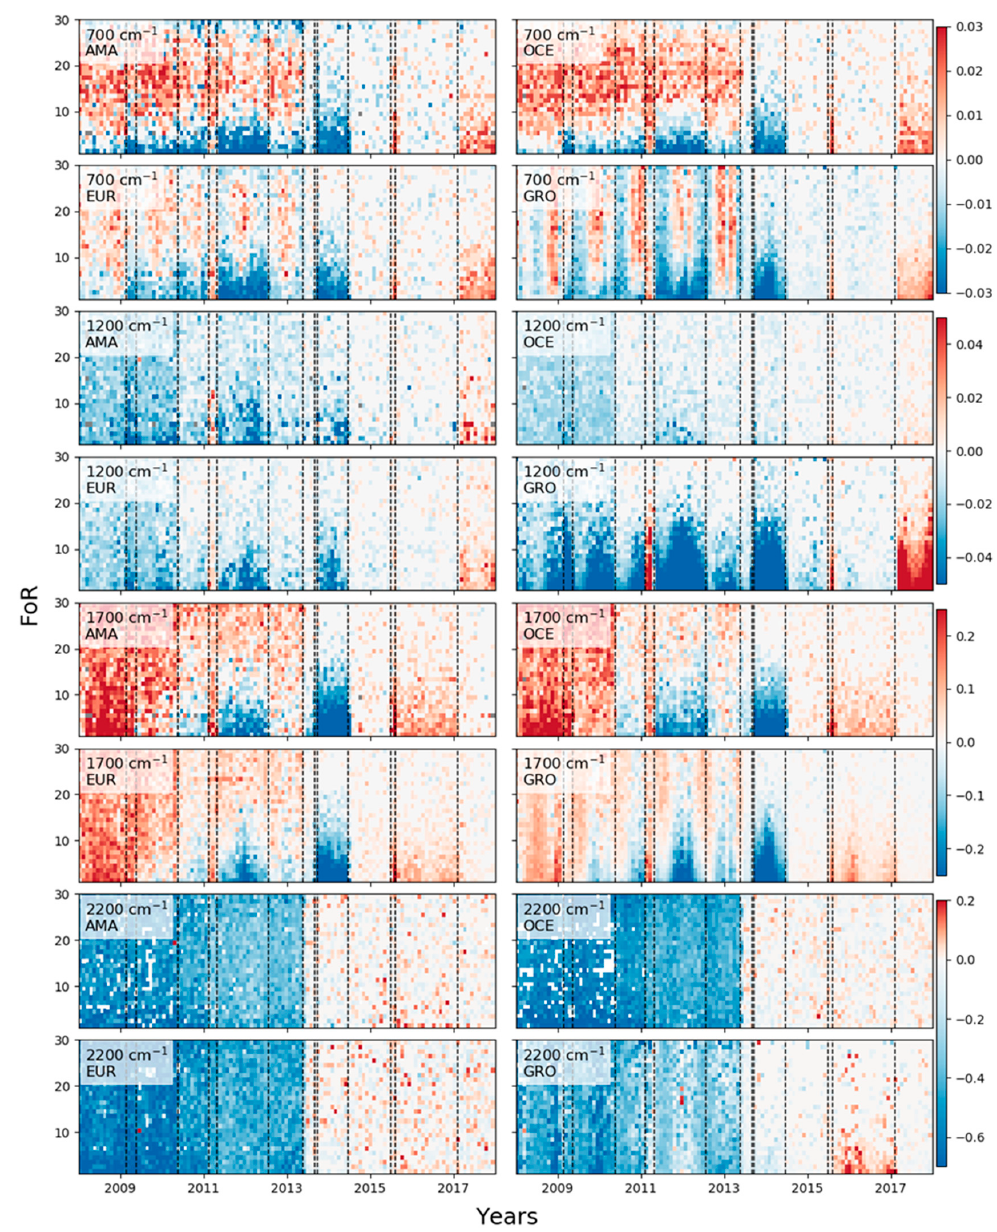
Figure 3. Evolution of the differences R reproc –R oper as a function of the Field of Regard (FoR) in the Amazon rainforest (AMA), Western Europe (EUR), the Indian Ocean (OCE), and Greenland (GRO) at 700, 1200, 1700, and 2200 cm -1 . The differences are shown as a percentage of the reprocessed L1C. Gray pixels correspond to no data with the right FoR. The vertical dashed lines correspond to L1 processing updates. Note that the color bar limits are different for each wavenumber.